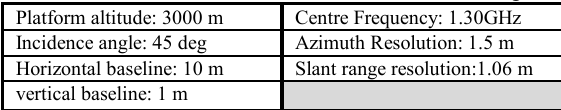
Table 1: The characteristics of the simulated images Platform altitude: 3000 m